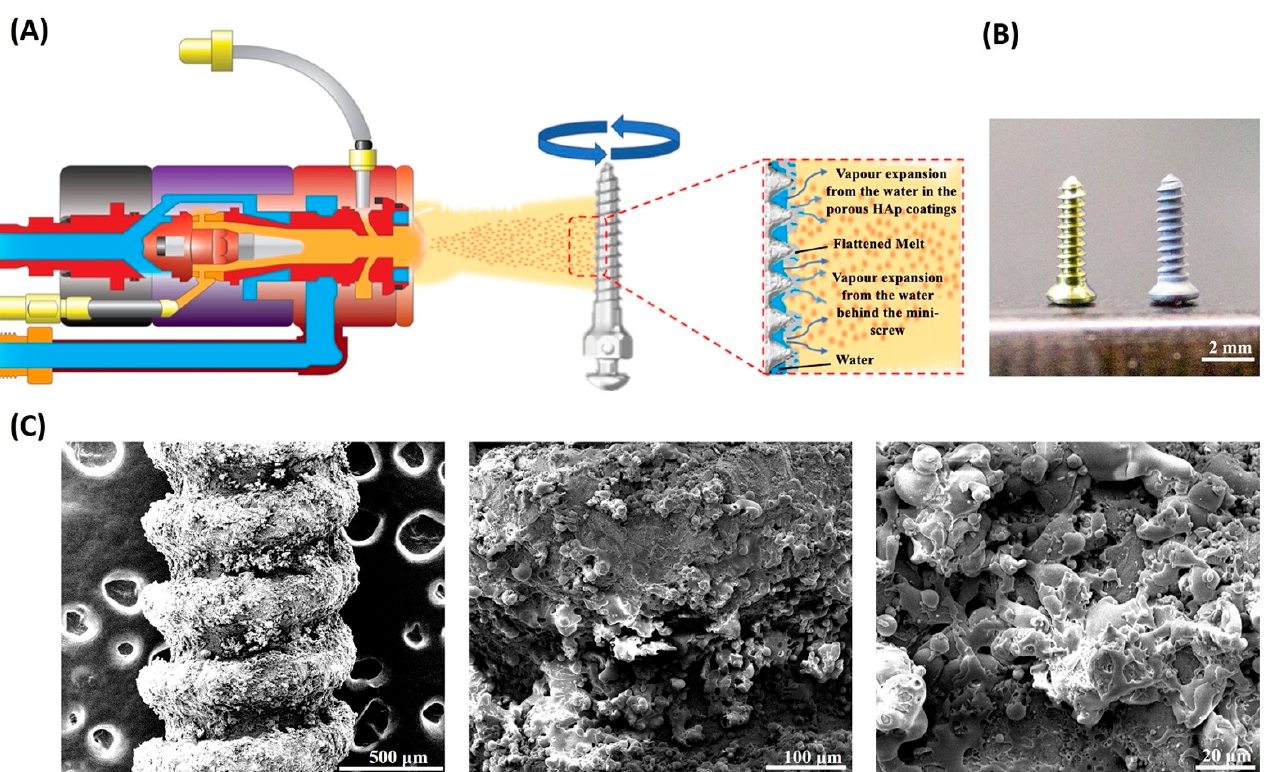
Figure 6. Preparation of HAp, Zn-doped HAp, and Zn-Sr-Mg-doped HAp coatings on titanium implants using the VIPF-APS technique. ( A ) The titanium implant was roughened and then sprayed with a thin layer of HAp coatings. After immersion in pure water, quick sprays were applied repeatedly, and the desired thickness of HAp coating was produced. ( B ) Left: titanium implants; right: titanium implants with the porous HAp coating. ( C ) Scanning electron microscopy images of HAp coatings on implant surfaces at different magnifications. (Magnification: 160 × , 600 × , 2500 × ; from left to right) VIPF-APS: vapor-induced pore-forming atmospheric plasma spraying.